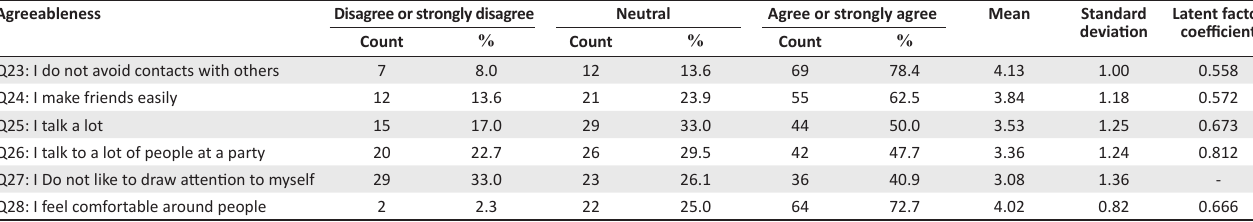
TABLE 5: Descriptive statistics for the construct of agreeableness.